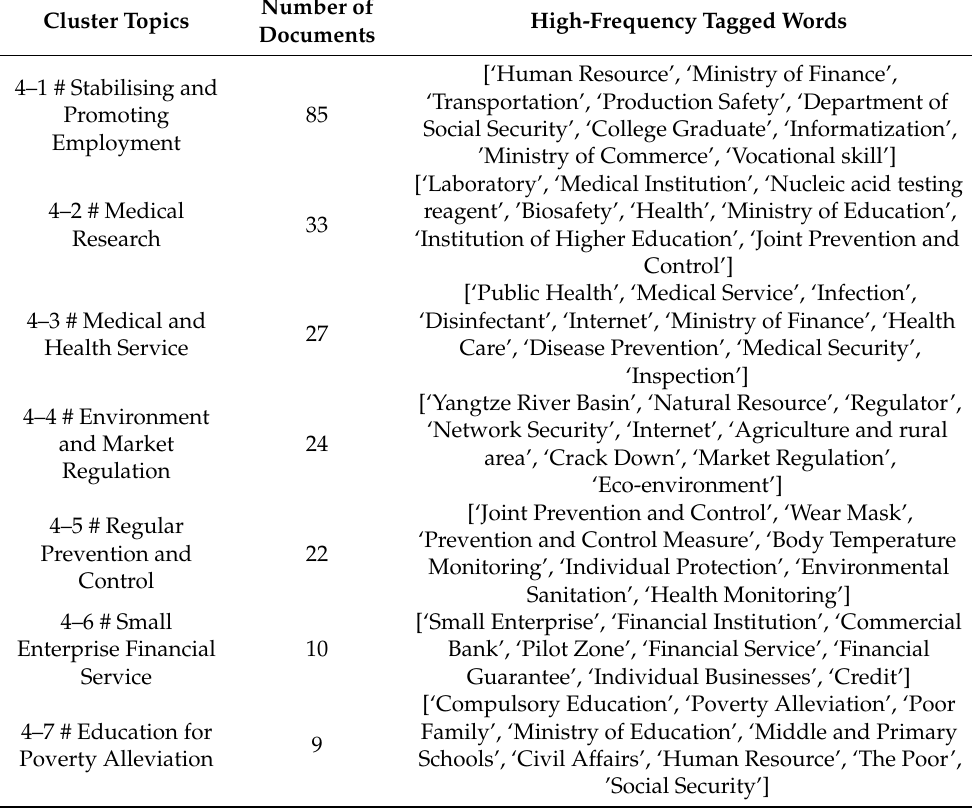
Table 4. Topic contents in Stage